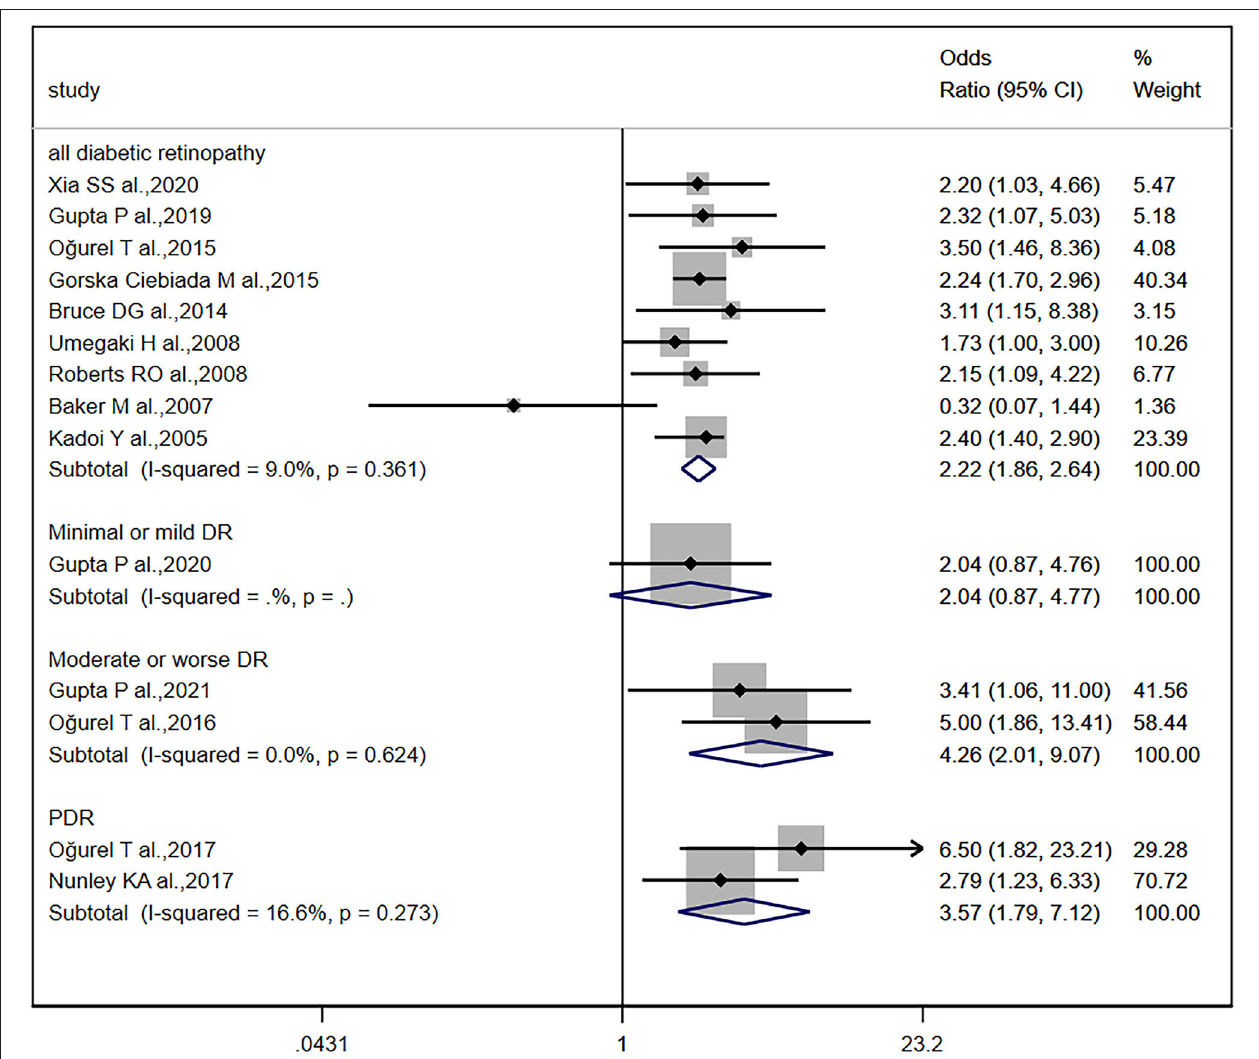
FIGURE 5 | Grades of diabetic retinopathy and cognitive impairment. Forest plot and pooled estimates of the association between diabetic retinopathy and cognitive impairment, stratified by the grade of diabetic retinopathy. Each study corresponds to a horizontal line and a square. The size of the square represents the weight of the study in the pooled analysis, and the length of the horizontal line represents the 95% confidence interval (CI). The pooled fixed-effect estimate and its 95% CI are represented by a dashed vertical and diamond. The vertical at 1 indicates that diabetic retinopathy is not associated with cognitive